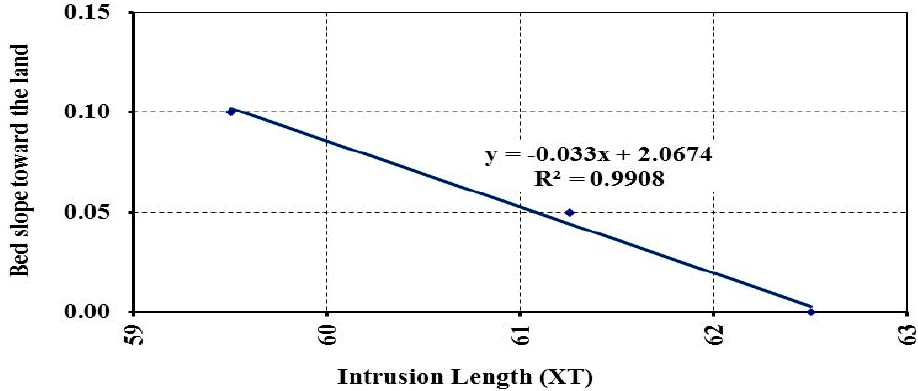
Figure 8. Relationship between bed slope toward the land side and intrusion length (X T ) .